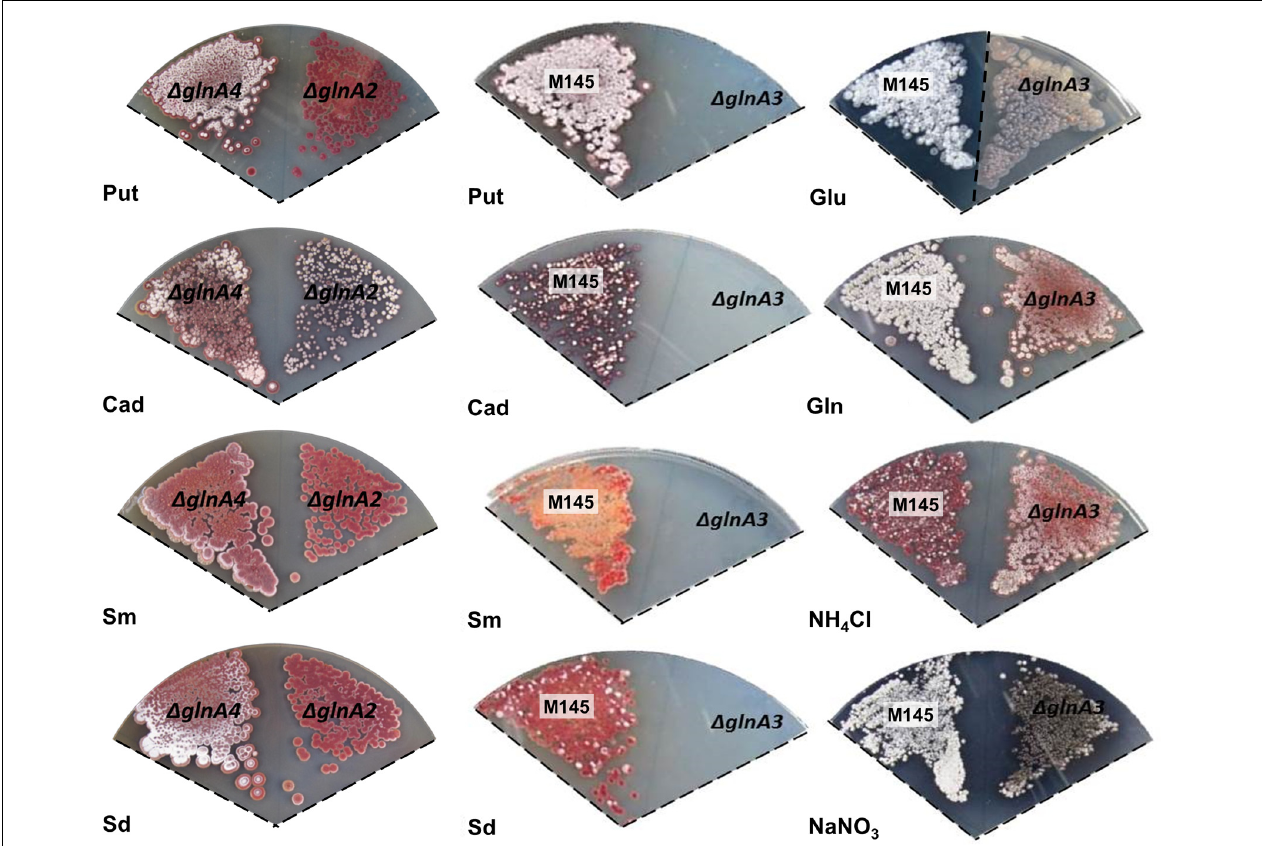
FIGURE 3 | Physiological role of the glnA3 gene product in S. coelicolor M145 cells grown in the presence of polyamines. (A) Phenotypic comparison of parental strain S. coelicolor M145 and (cid:49) glnA2, (cid:49) glnA3, and (cid:49) glnA4 mutants grown on defined Evans medium supplemented with Put – putrescine dihydrochloride (200 mM), Cad – cadaverine dihydrochloride (50 mM), Sm – spermine tetrahydrochloride (25 mM), Sd – spermidine trihydrochloride (25 mM) as well as on Glu – monosodium glutamate (50 mM), Gln – glutamine (50 mM), NH 4 Cl – ammonium chloride (50 mM) and NaNO 3 – sodium nitrate (50 mM) as sole nitrogen source. Each panel represents observations on a single agar plate, except the phenotypic analysis of the glnA3 mutant and parental strain in the presence of glutamate has been documented on two separate agar plates as indicated by the dotted line. Deletion of glnA3 resulted in the no-growth phenotype in the presence of high polyamine